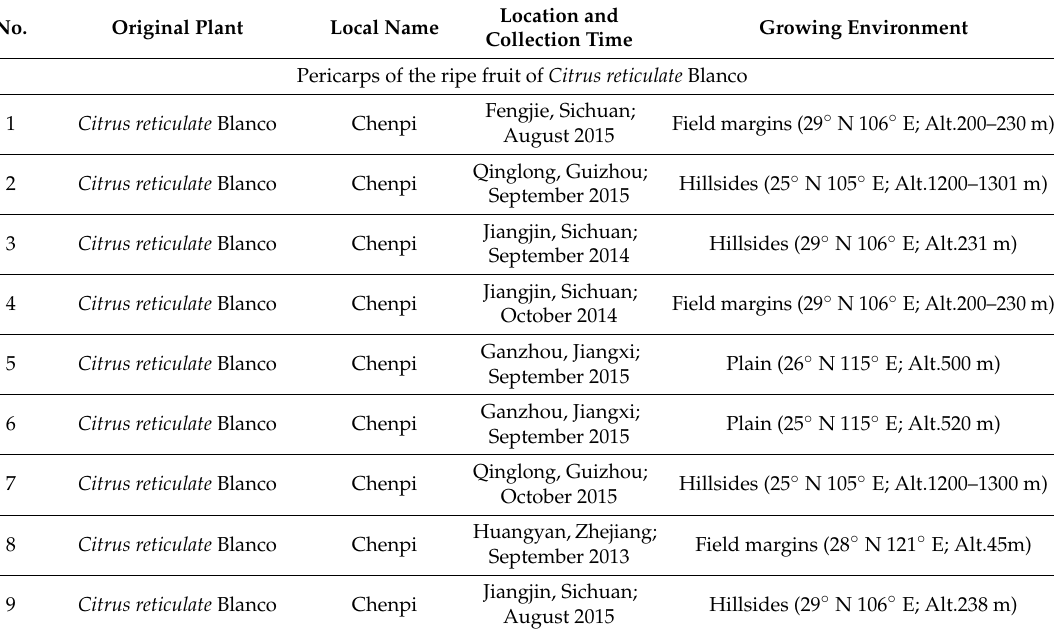
Table 3. Origins of the collected 37 QP, CP, ZS and ZQ